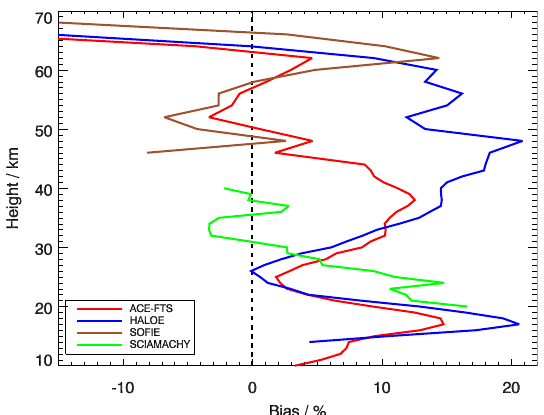
Figure 4. Bias estimation of MIPAS methane retrievals with respect to satellite reference instruments. The quantity shown is the mean × estimate over all latitudes of MIPAS − REF REF